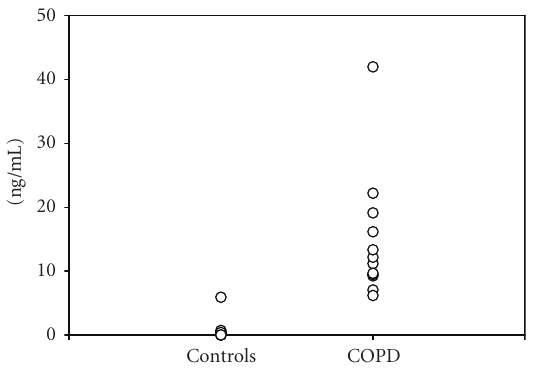
Figure 2: Concentration of sTREM-1 in serum of healthy controls (controls) and patients with